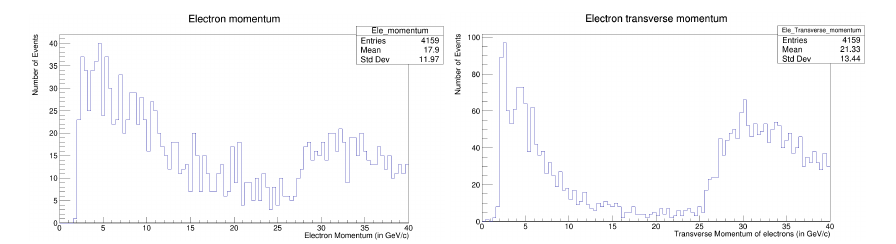
Figure 7. Example histograms produced by the reconstruction workflow.